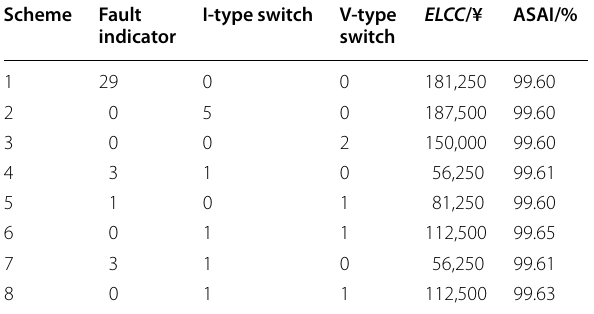
Table 6 Solution results when ASAI lim is 99.6% Scheme